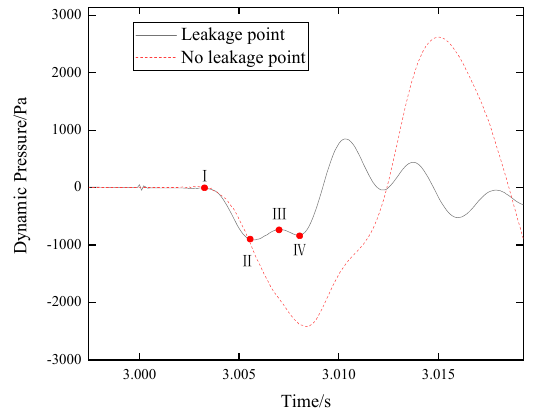
Figure 13. Dynamic pressure curve after introducing the disturbance signal into the pipeline with or without a leakage hole.